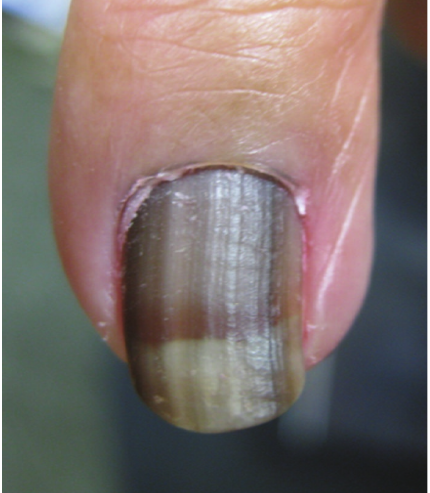
Figure 3: Drug-related melanonychia secondary to hydroxyurea- induced melanocytic